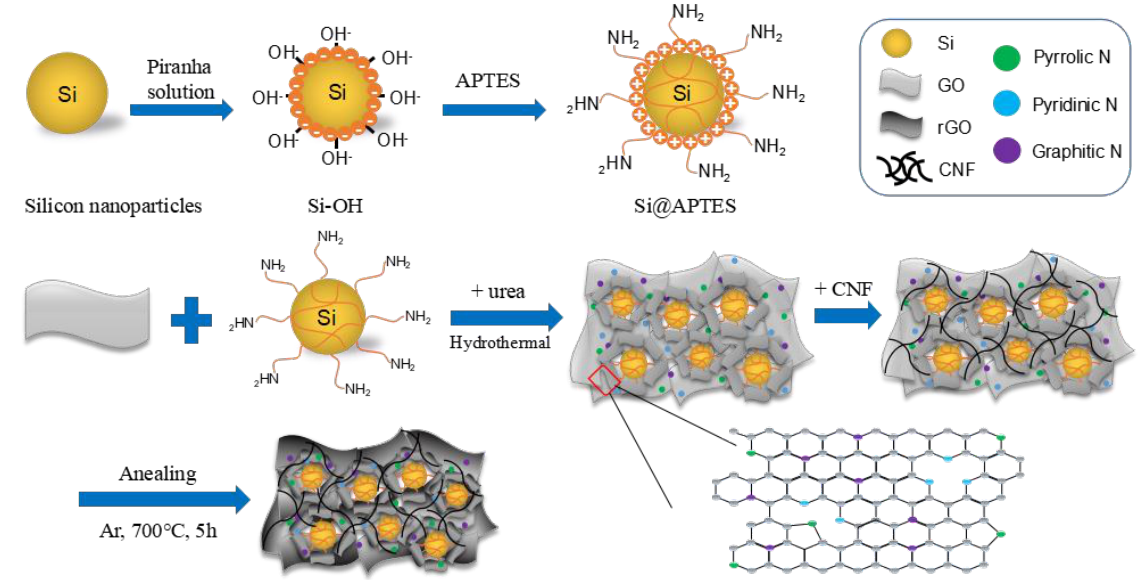
Figure 1. Schematic diagram of the preparation process of Si/N-doped rGO/CNF and Si/N-doped rGO composite material.